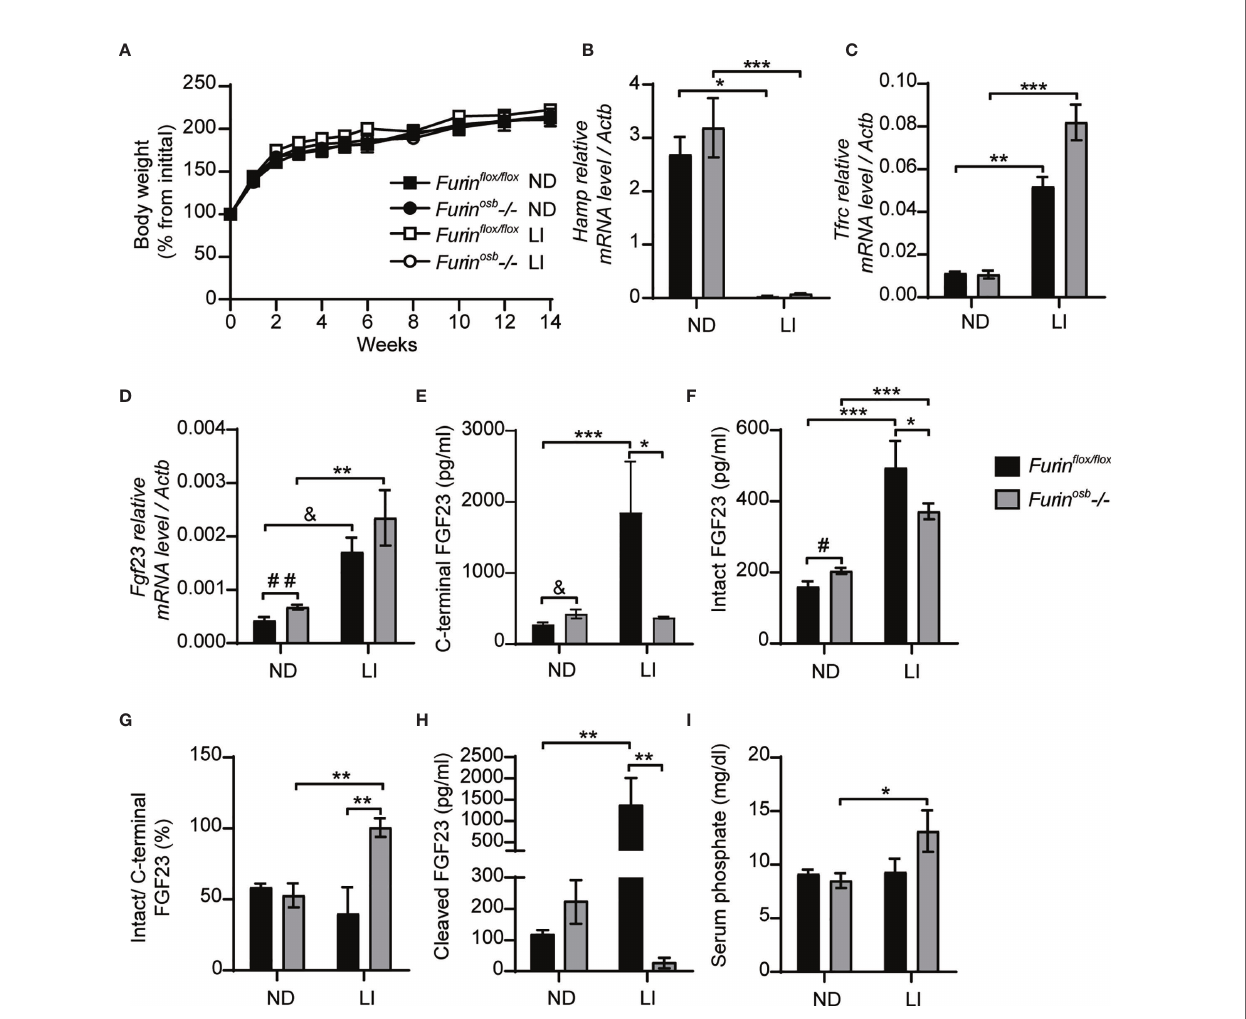
FIGURE 2 | Impaired FGF23 processing in Furin osb-/- mice following iron restriction. Furin fl ox/ fl ox (n=3-5) and Furin osb -/- (n=7-8) 21-day-old mice were fed normal chow diet (ND) or a low iron diet (LI) for 14 weeks. (A) Body weight growth curve presented as percentage of initial body weight. (B, C) Expression of iron-regulated genes in liver. Hepcidin ( Hamp ) expression (B) . Transferrin receptor ( Tfrc ) expression (C) . (D) Fgf23 expression in long bone. (E – H) Plasma level of C-terminal FGF23 (E) , intact FGF23 (F) , percentage (%) of intact over C-terminal FGF23 (G) and cleaved FGF23 levels (H) , calculated as (C-terminal FGF23) - (intact FGF23). (I) Serum phosphate levels. Results represent the mean ± SEM. * P < 0.05, ** P < 0.01, and *** P < 0.001, by 2-way ANOVA with Bonferroni ’ s multiple comparisons test or by Student ’ s t-test (D – F) #: P <0.05; ##: P <0.01; &: 0.05< P